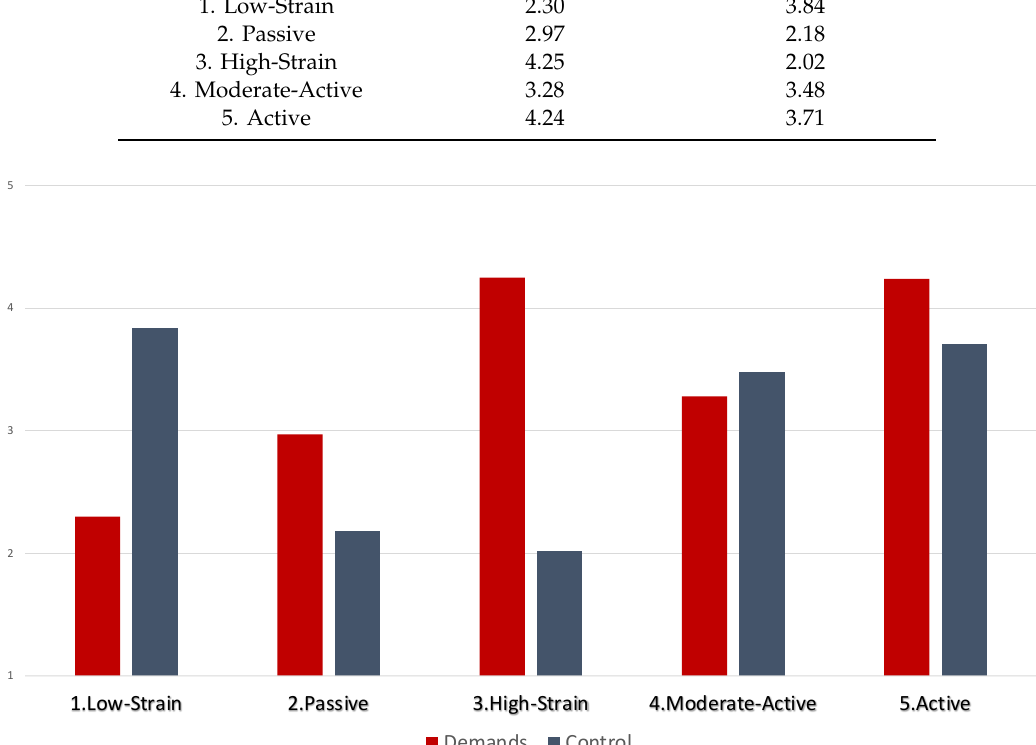
Figure 1. Demands and Control Profiles.